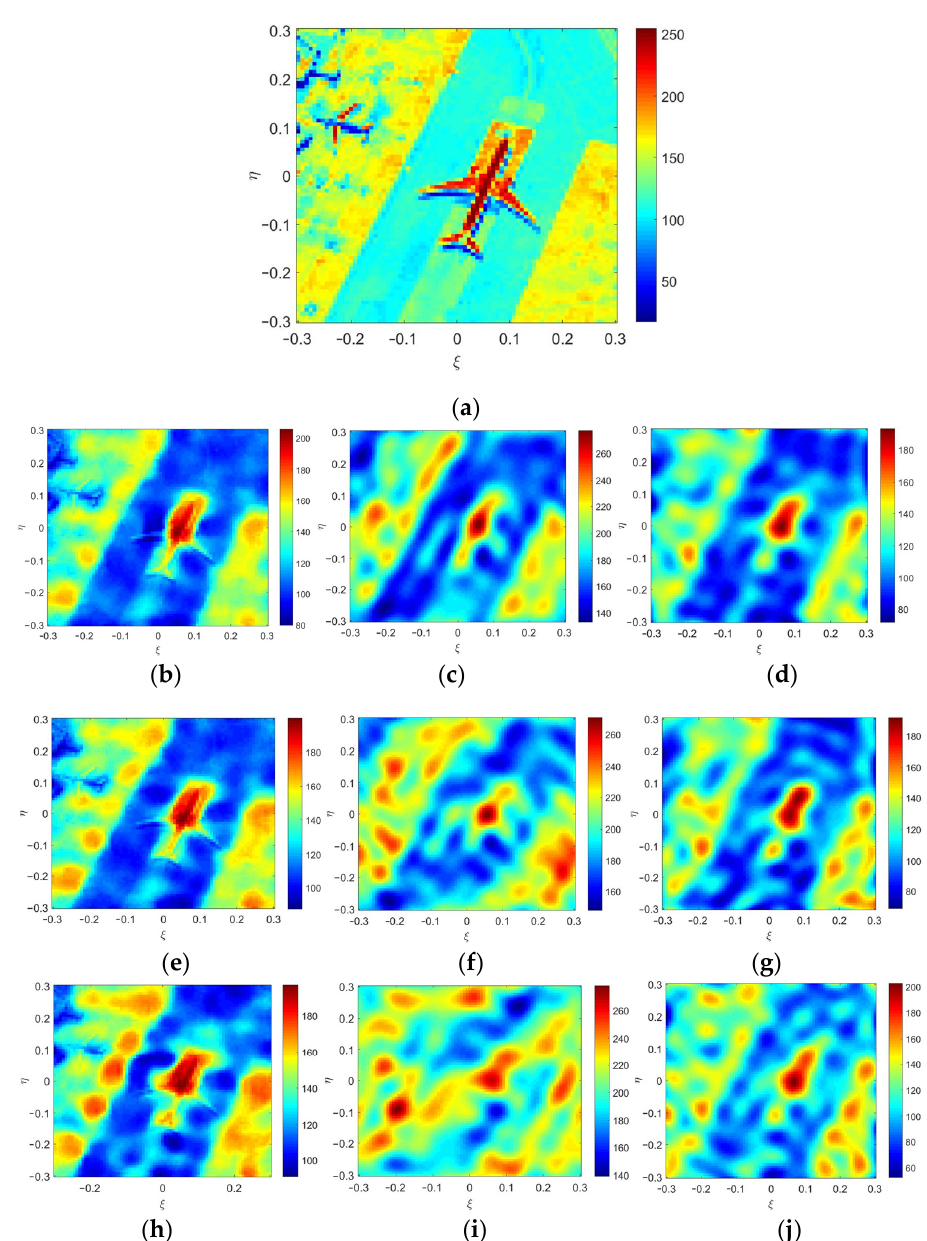
Figure 7. The brightness temperature images reconstructed by the different methods at variable noise intensities. ( a ) Original scene. ( b ) The IASR-CNN method at a 0.1 noise intensity. ( c ) The grid method at a 0.1 noise intensity. ( d ) The AFF method at a 0.1 noise intensity. ( e ) The IASR-CNN method at a 0.2 noise intensity. ( f ) The grid method at a 0.2 noise intensity. ( g ) The AFF method at a 0.2 noise intensity. ( h ) The IASR-CNN method at a 0.3 noise intensity. ( i ) The grid method at a 0.3 noise intensity. ( j ) The AFF method at a 0.3 noise intensity.